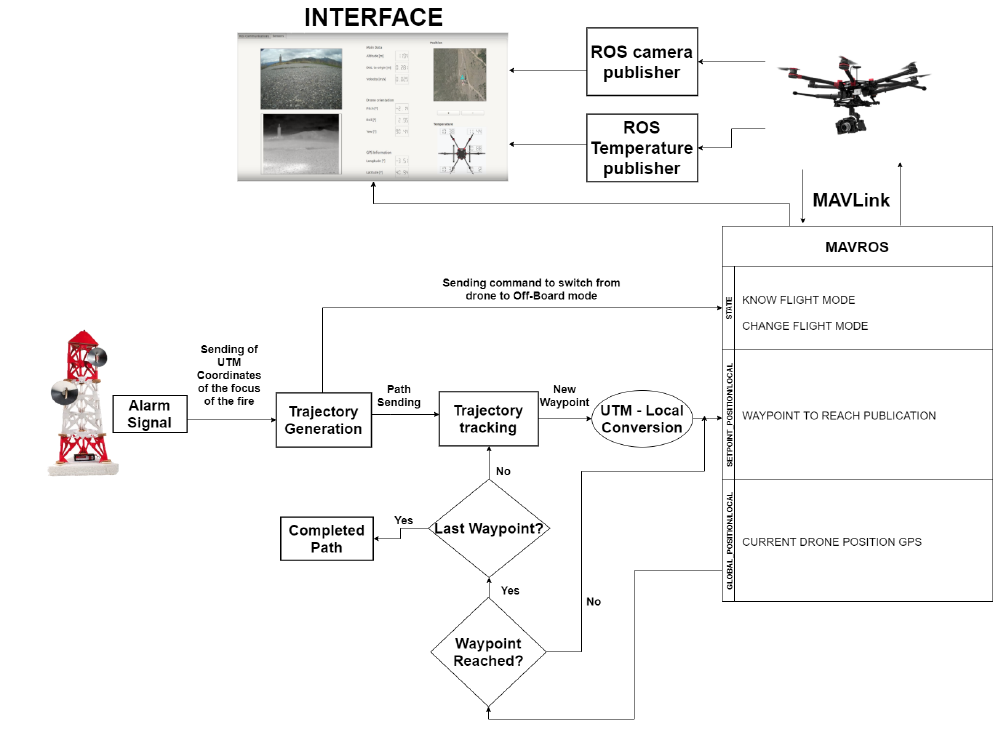
Figure 6. System overview.